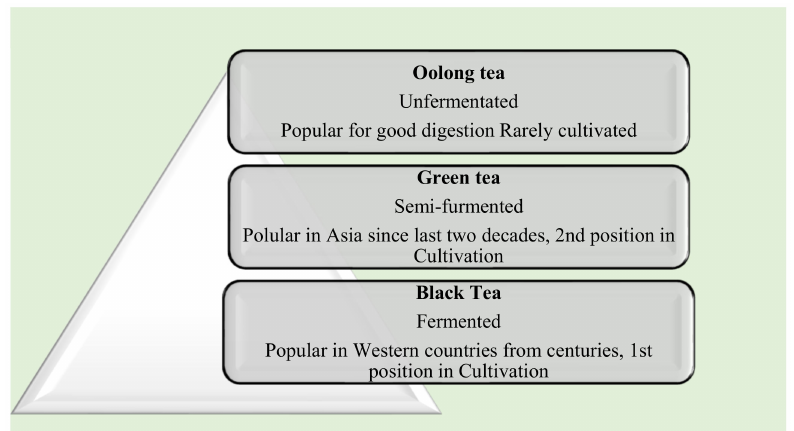
Figure 3. Tea types and their demands.